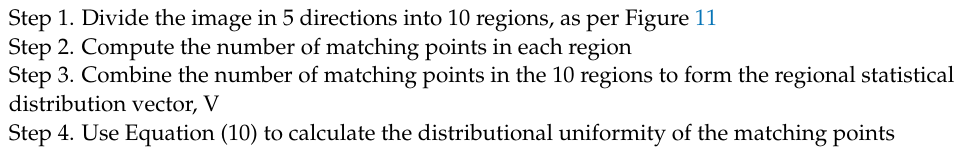
Algorithm 2. Computing Distributional Uniformity of the Matching